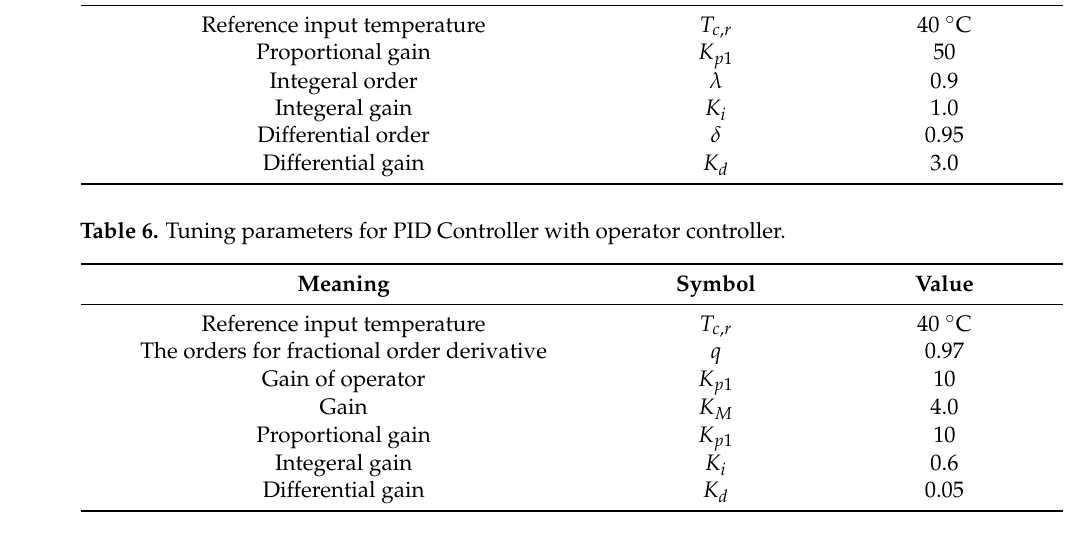
Table 7. Tuning parameters for PID Controller without operator